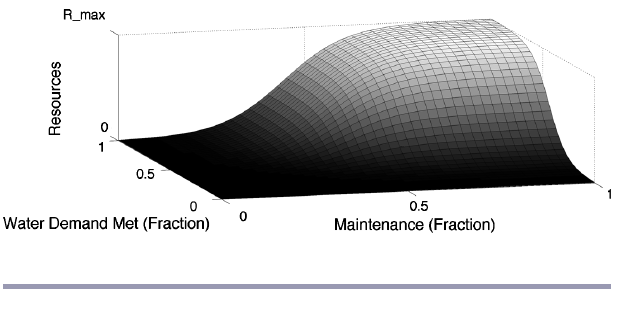
Fig. 3 . General form for resource generation response to increased maintenance (X) and increased fraction of water demand met (V).